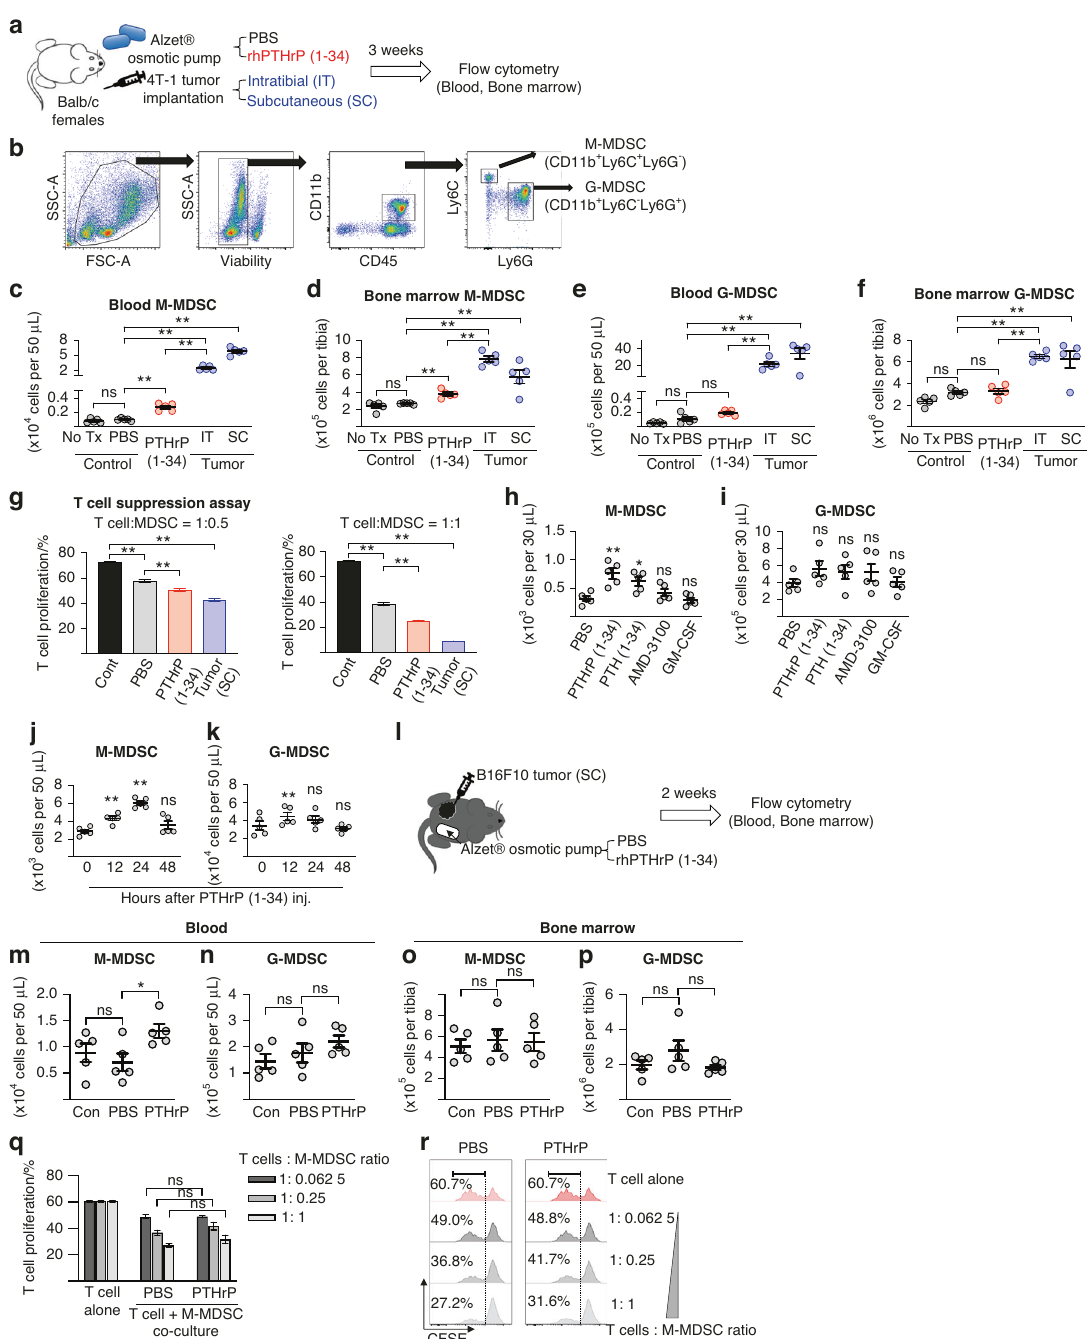
Fig. 1 PTHrP increases the number of monocytic, but not granulocytic, MDSCs in the circulation and bone marrow, and PTHrP does not further augment the immunosuppressive activity of monocytic MDSCs in tumor-bearing mice. a Schematic representation of the in vivo experiments shown in Panels c – g . b Flow cytometric analysis gating scheme. CD11b + Ly6C + Ly6G − or CD11b + Ly6C − Ly6G + blood or bone marrow cells in the viable CD45 + cell population were de fi ned as M- or G-MDSCs, respectively. c – f Flow cytometric results showing that three weeks of continuous infusion of PTHrP (1 – 34; 80 μ g·kg − 1 daily) increased the number of M-, but not G-, MDSCs in the blood and bone marrow compared with no treatment or PBS infusion. g T-cell suppression assay using CFSE-labeled T cells (isolated from the spleens of nontumor-bearing Balb/C